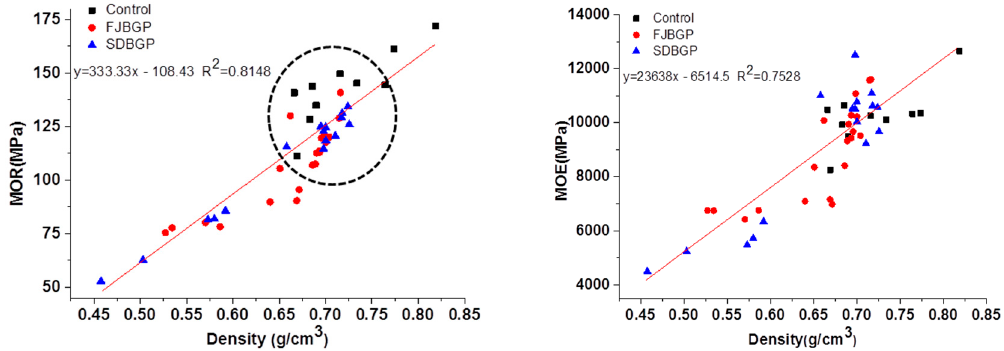
Figure 2. Relationships between MOR / MOE and density. Details of the dotted circles are explained in the text. FJBGP: bamboo grid packing collected from Fujian; SDBGP: bamboo grid packing collected from Shandong.